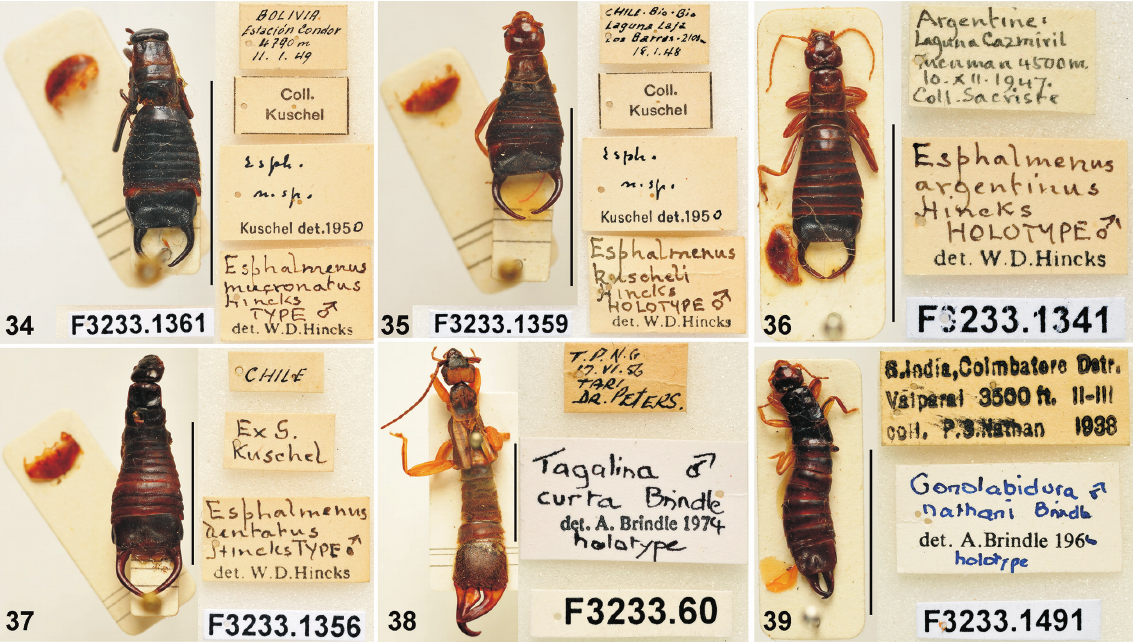
Figs 34–39. Holotypes (♂) of Pygidicranidae and Labiduridae in the collection of the